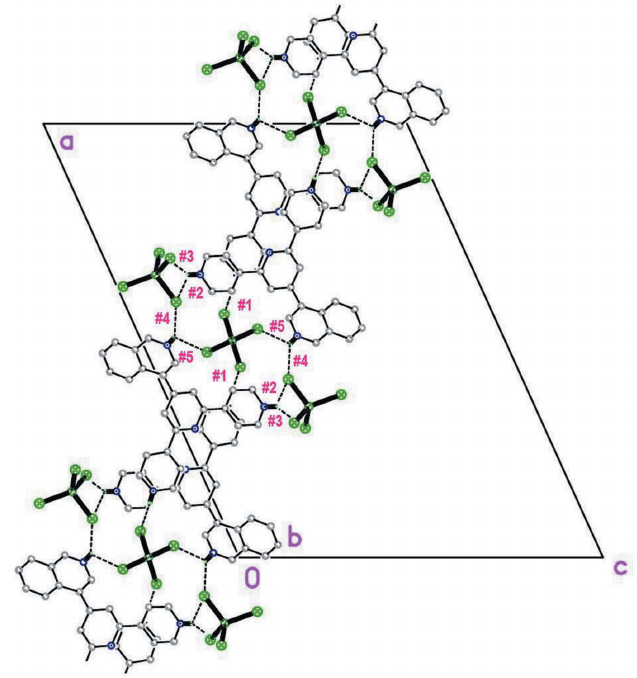
Figure 2 The broad (010) planar structure, shown sideways, along b 2 :